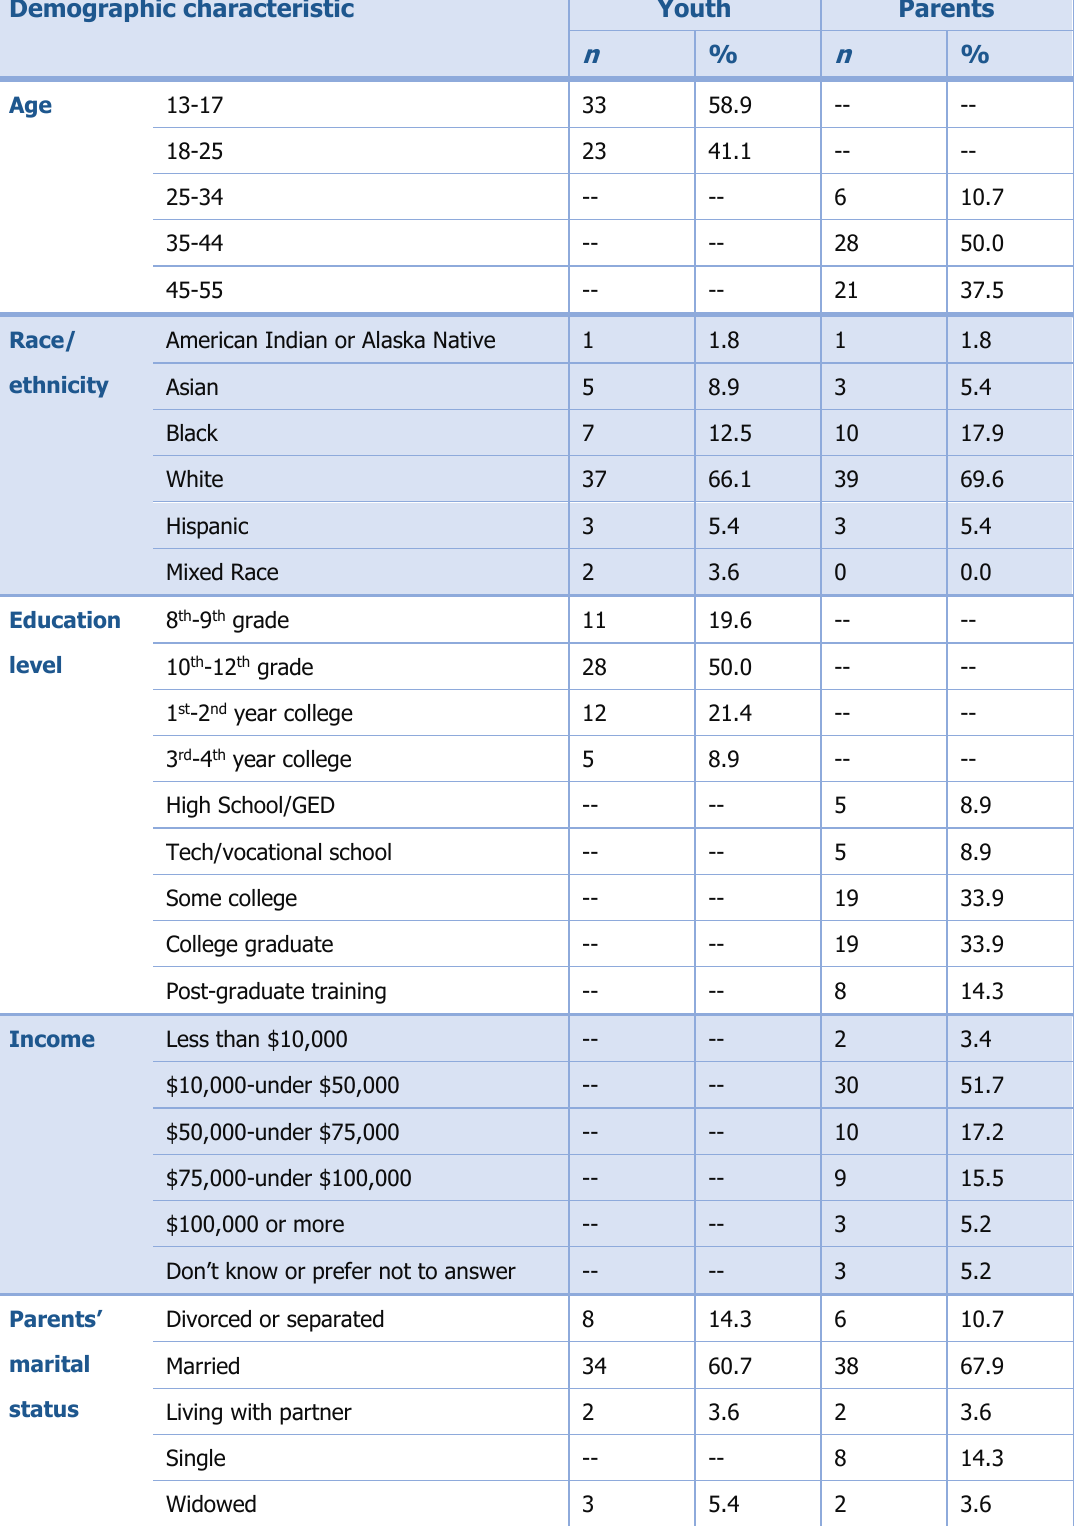
Table 1. Demographic Information About Study Sample (N = 56 Parent–Youth Dyads) Demographic